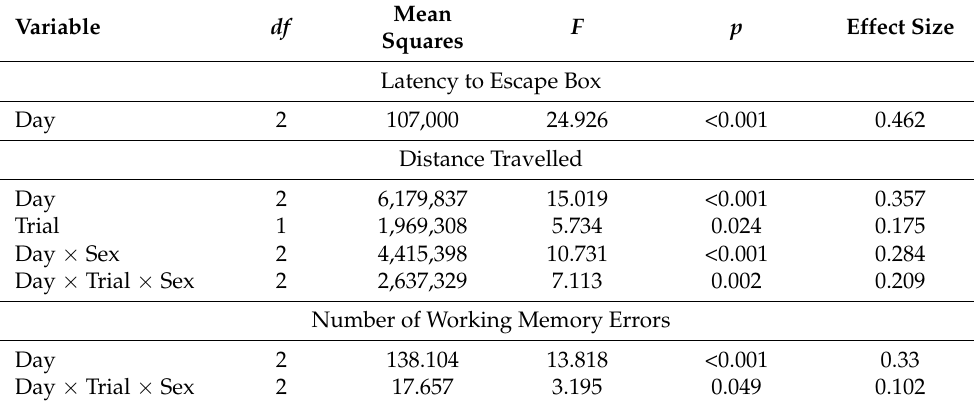
Table 2. ANOVA Summary Table for the Reversal Learning Phase.